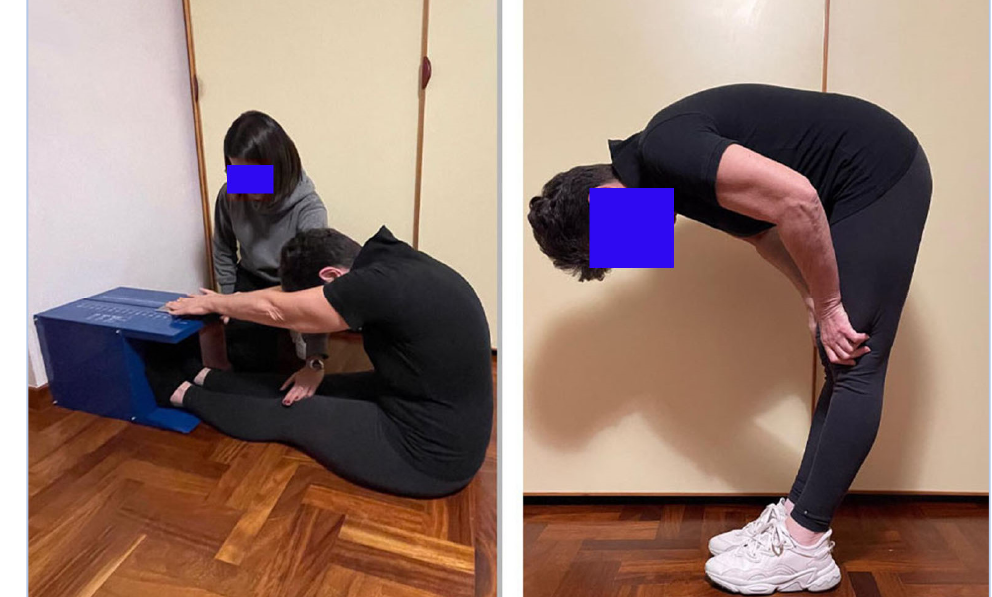
Figure 2. On the right: static stretching exercise performed by the participants of the two experi- mental groups; the trunk flexion is supported by the arms, which are gripped on the knees. On the left: sit-and-reach test to assess the